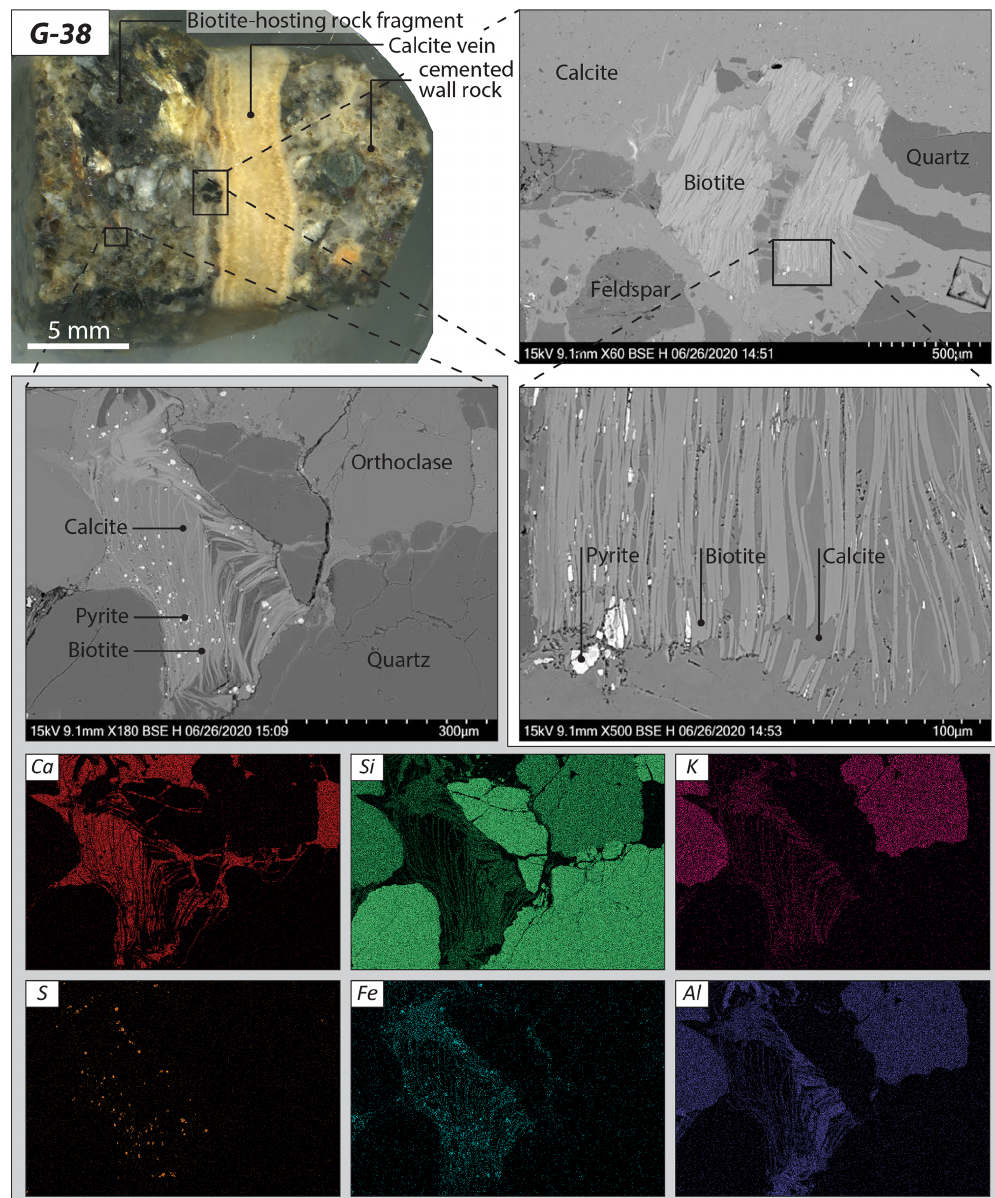
Figure 5. Optical, backscattered-electron, and energy-dispersive X-ray imagery of sample G-38, which hosts abundant biotite in the wall rock. Pyrite is present in the vicinity of biotite grains and in between biotite lamellae, which are also pervasively surrounded by